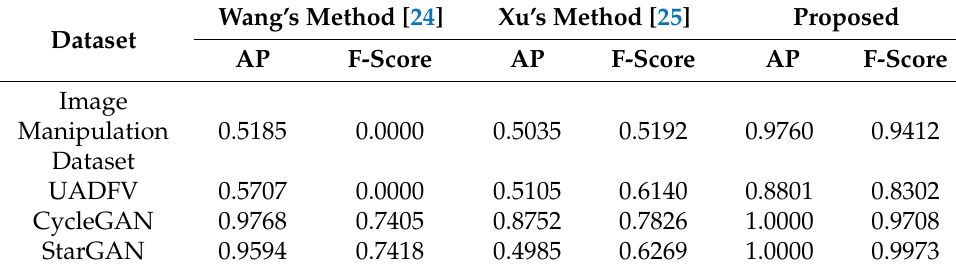
Table 4. Comparison with state-of-the-art